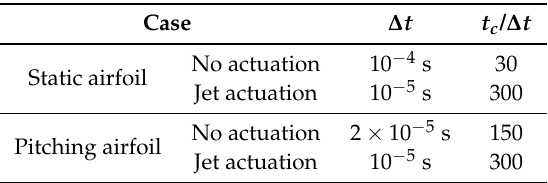
Table 2. Time steps of the current